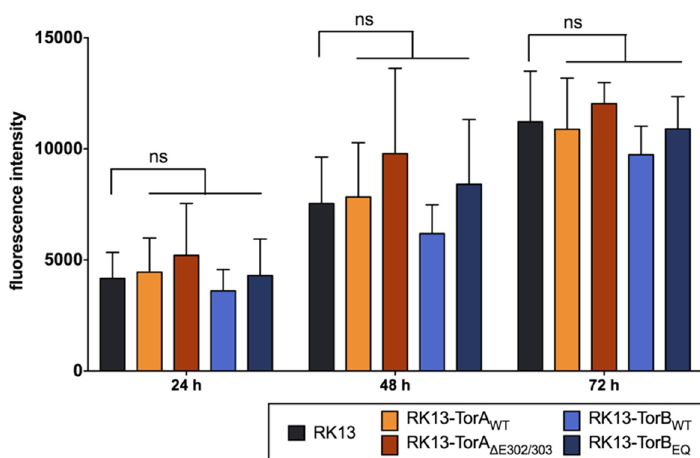
Figure 5. Cell viability of the modified cell lines. RK13 control and stably expressing RK13-GFP-TorA and -TorB cells were seeded with 1 × 10 4 cells per well and at 24, 48, and 72 h post seeding the mitochondrial activity was measured (in fluorescence intensities) via the Presto Blue Assay. Shown is the mean of three independent experiments, ns = statistically not significant.